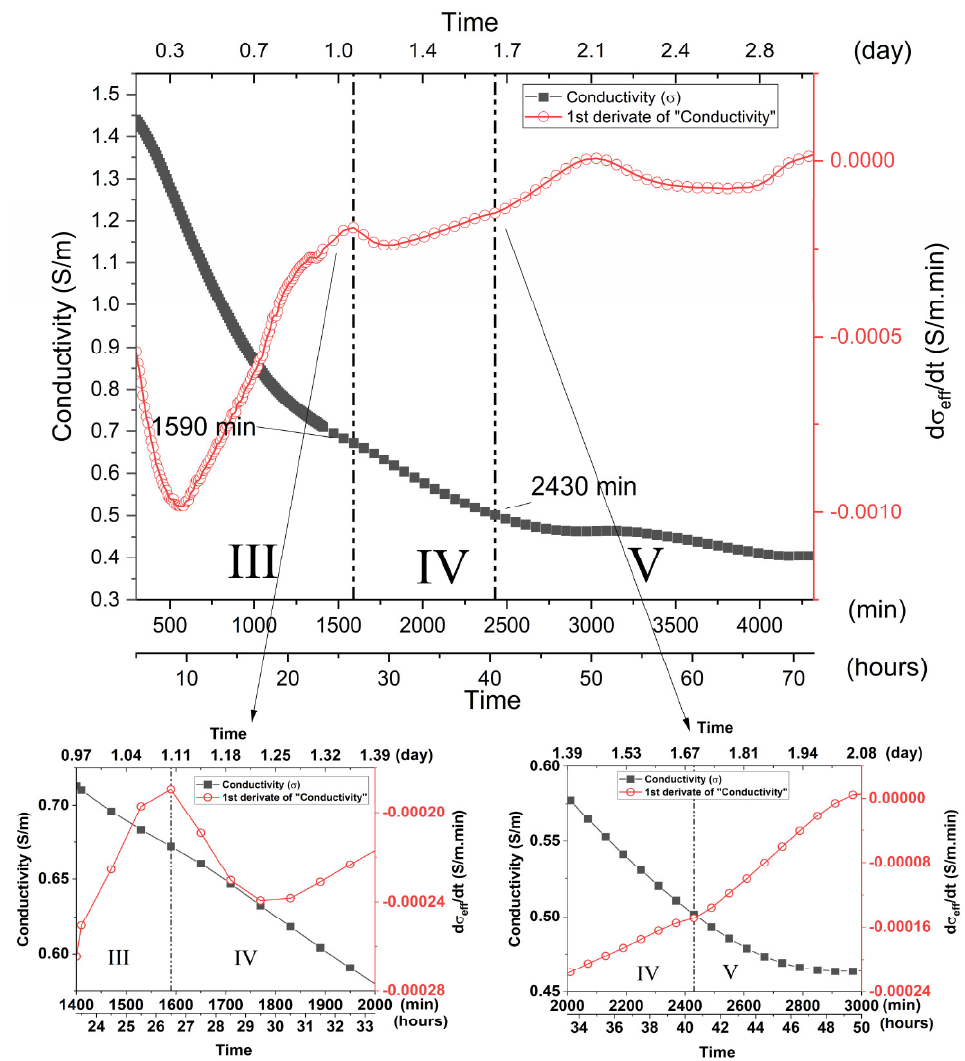
Figure 8. Electrical conductivity, σ eff , and its derivative, d σ eff /dt, as a function of the geopolymeriza- tion time, highlighting regions III–V. MK1 sample. Insets illustrate the inflection points of the d σ /dt curve adopted as a delimiter between the referred stages.